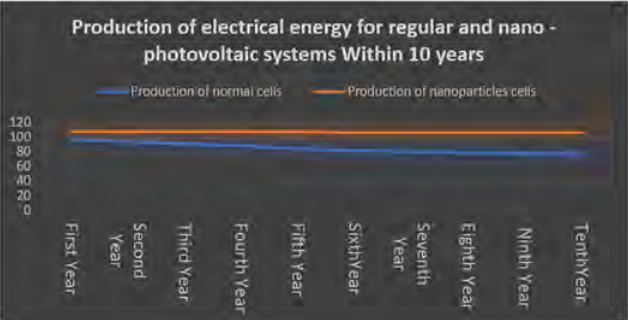
Figure 14. Economic value of long-term sustainability of solarcells (time efficiency) (”Renewable Energy Technologies Screen”,